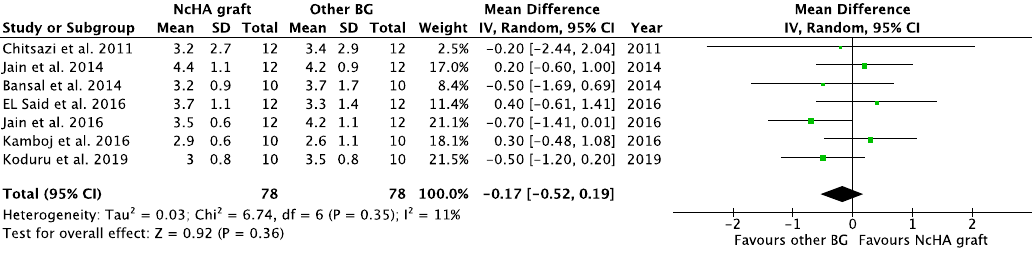
Figure 4. Forest plots demonstrating the comparison of NcHA graft versus other BG (PPD reduction). NcHA: nanohy- droxyapatite; BGs: bone graft; IV: inverse variance; SD: standard deviation; Total: number of patients; 95% CI: confidence interval.